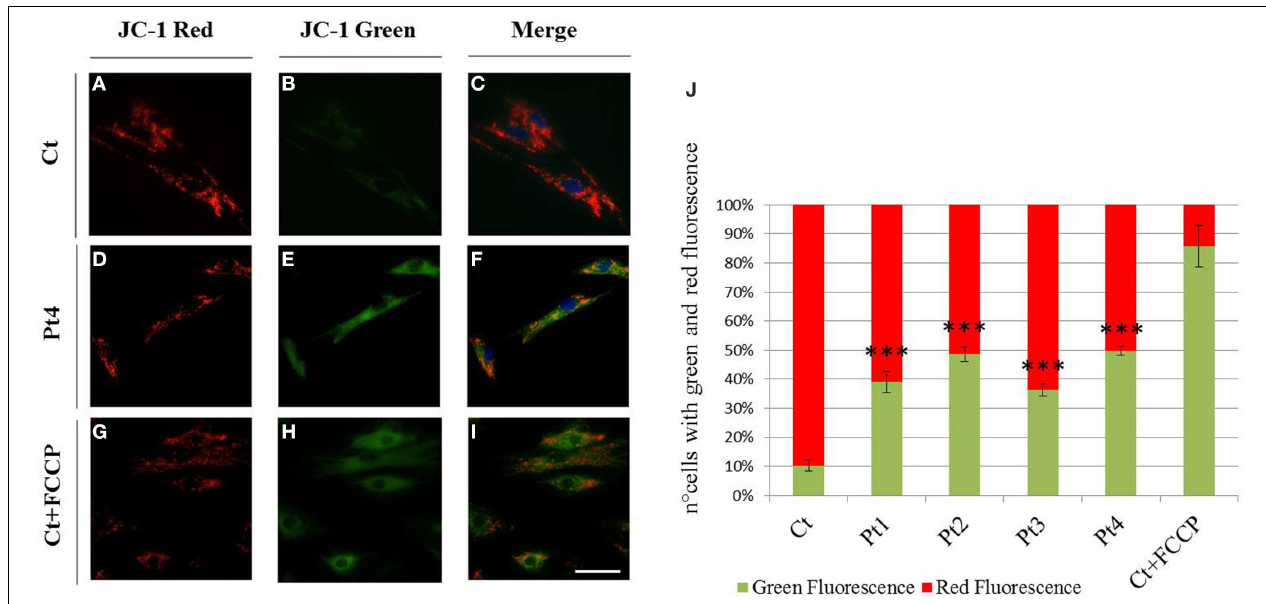
(H,I) . Scale bar, 50 µ m. (J) Quantification of cells observed with green and red fluorescence (expressed in percentage). Data were from three independent experiments, each with 50 counted cells. Mutant fibroblasts (Pt1, Pt2, Pt3, Pt4) presented a higher number of cells with green fluorescence ( ∼ 40–50%), than controls ( ∼ 10%). Test Chi 2 -Pearson, Pt vs Ct; p: 2,49E-06 (Pt1); p: 2,83E-09 (Pt2); p: 1,37E-05 (Pt3); p: 1,21E-09 (Pt4). ∗∗∗ p < 0 . 0001